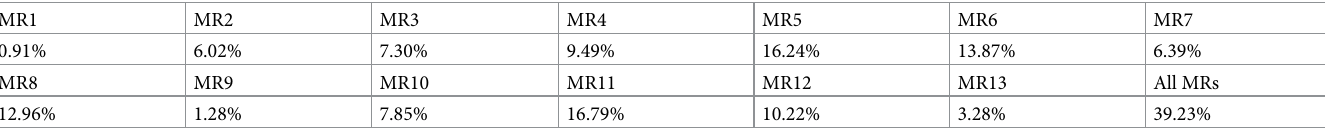
Table 3. Mutation scores of MRs for all